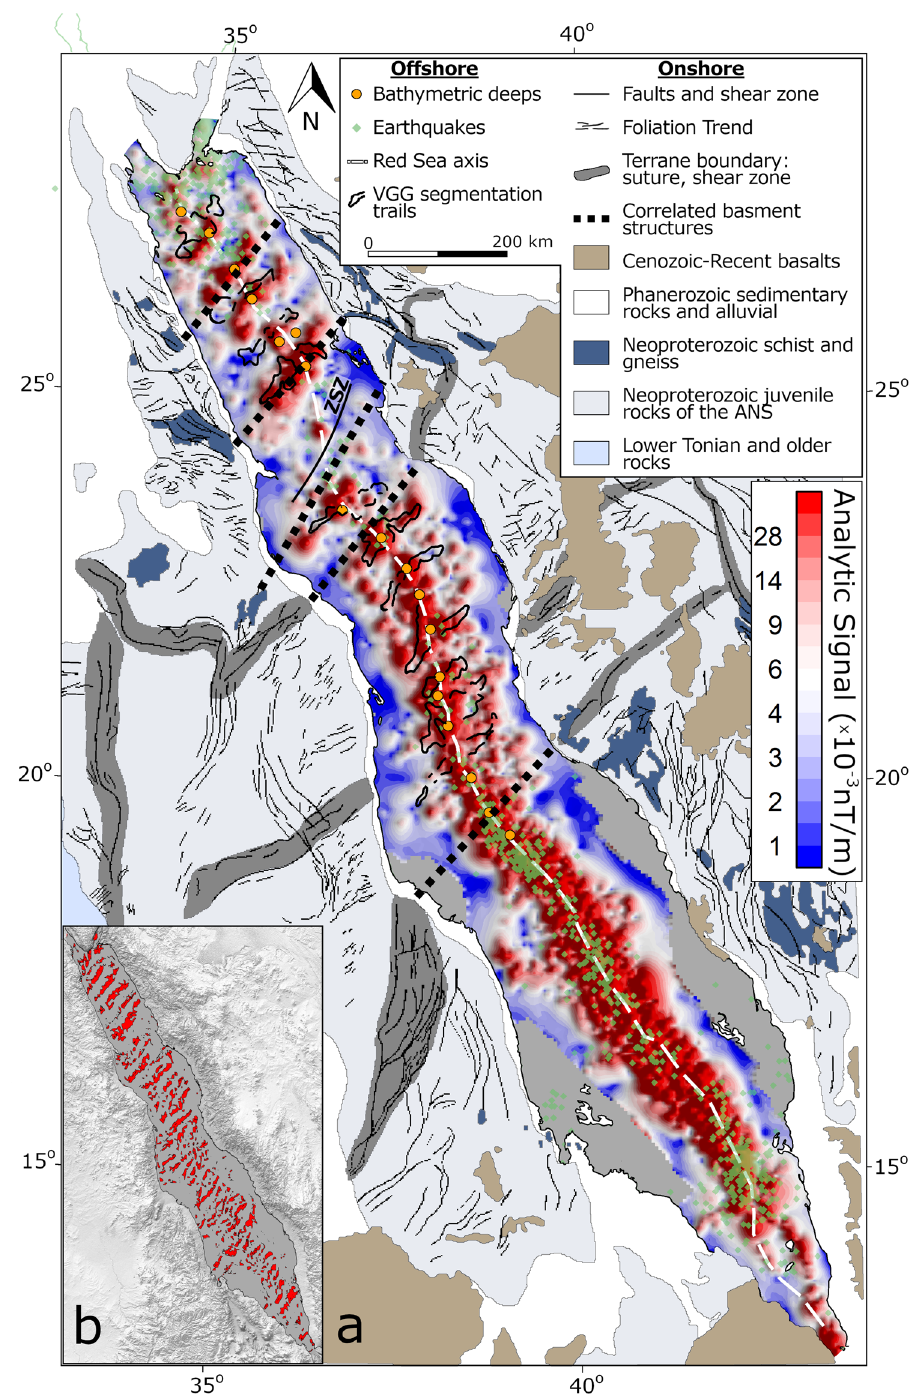
Figure 3. ( a ) Analytic signal of magnetic anomalies. The map shows bathymetry deeps (orange circles), earthquake locations (> 3.5 ML; green diamonds), mapped Vertical Gravity Gradient segments 10 (black contours) and the axis of the Red Sea (dashed white line). Onshore geology and correlated basement structures (tick black dashed lines; after Stern and Johnson, 2018) 48 . ZSZ is the Zabargad Shear Zone. ( b ) Edge detection filtered analytic signal data using “neon” algorithm